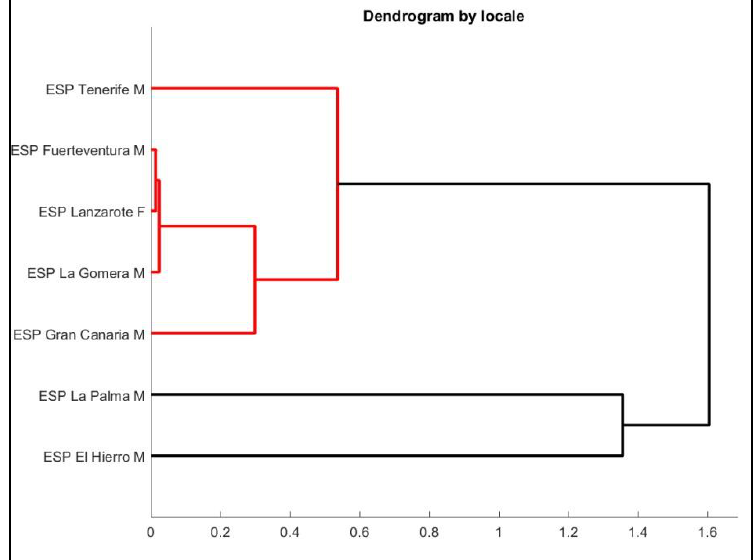
Figure 15. Dendrogram of SVO declarative vs. interrogative sentences by areas (vertical axis) and distance values along the horizontal axis.